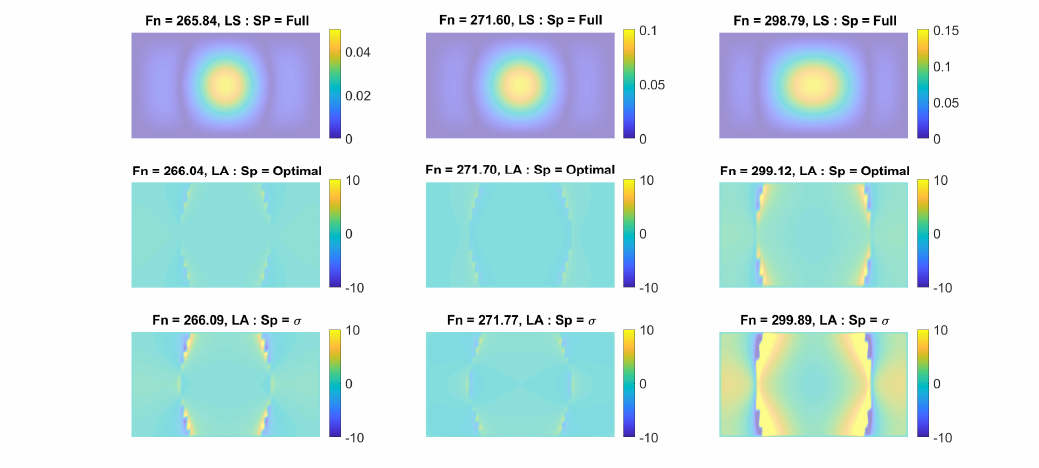
Figure 12. The first row of contours are the full finite element (FE) model displacements at the NNM solutions designated in Figure 11 for the full ROM model. The second row of contours are the percentage differences in the displacements fields of the optimal model with respect to the full model. The third row of contours are the percentage differences in the displacement fields of the optimal model with respect to the full model.